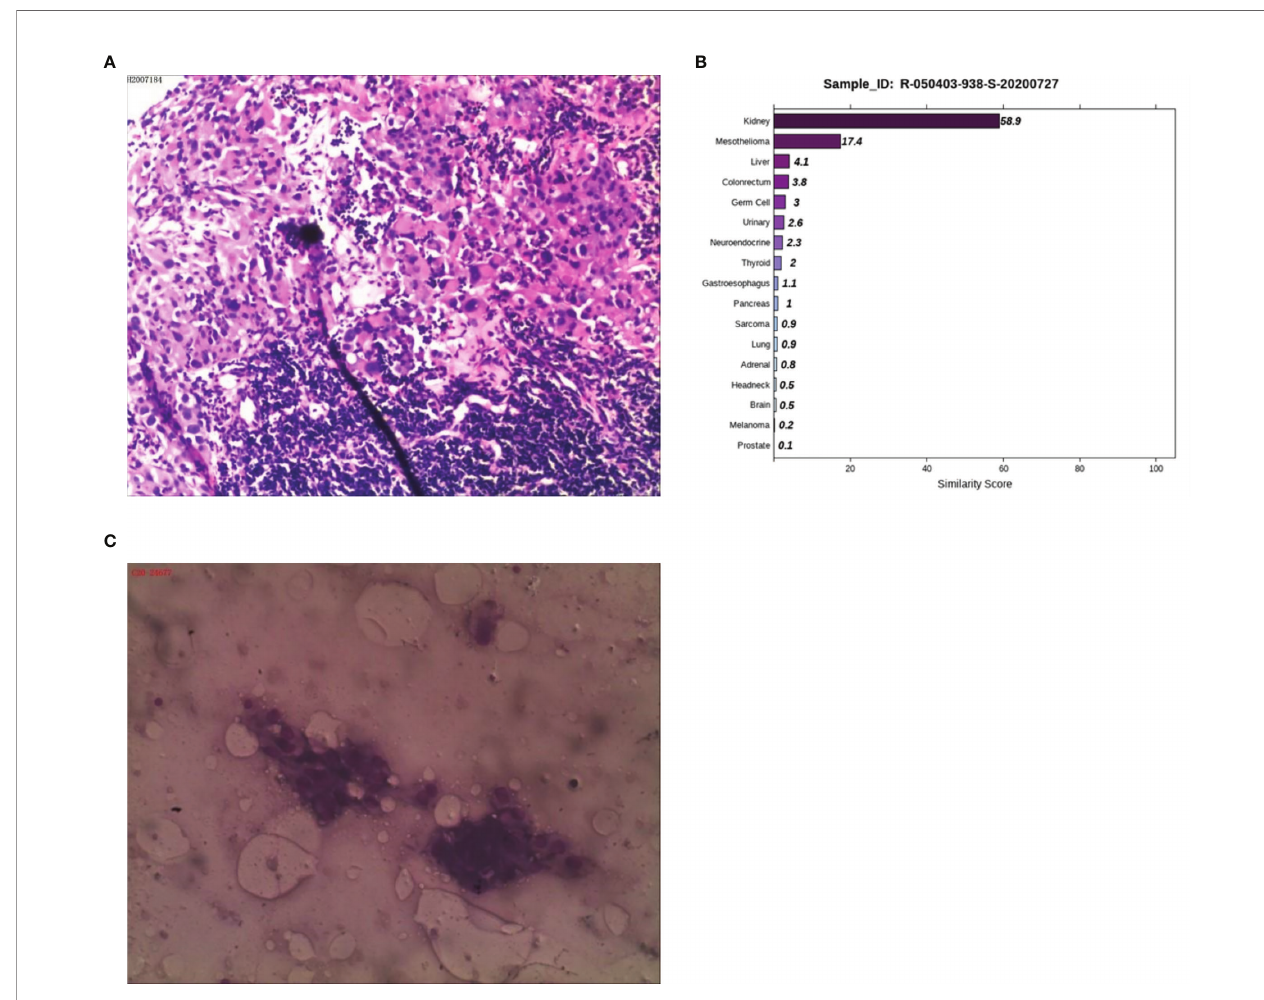
FIGURE 4 | Pathological, 90-gene expression assay and cytology results of case 4. (A) The pathological diagnosis of the resected specimens was malignant tumors which tend to be metastatic poorly differentiated. Immunohistochemistry staining: CK (+++), CK7 (-), CK20 (-), Villin (-), TTF1 (-), SATB-2 (+), MelanA (+/-), NapsinA (-), P40 (-), CR (-), CK5/6 (-), CDX-2 (-), S-100 (-), Des (-), SOX-10 (-), HMB45 (-). (B) The 90-gene expression assay indicated that the similarity score of metastatic renal cancer and liver cancer on the left cervical lymph node was 58.9 and 17.4, respectively. (C) The cytology results showed cancer cells in the kidney puncture